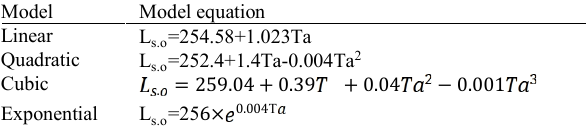
Table 2. Equations of estimated curves based on